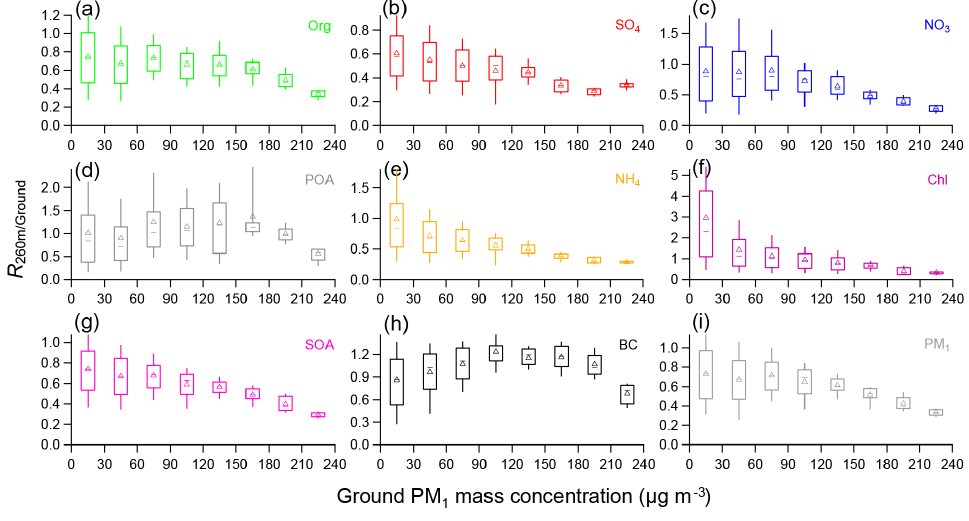
Figure 7. Variations of the ratios of 260m to ground ( R 260m/Ground ) for each species as a function of PM 1 mass concentrations at ground level. The data are grouped into eight bins according to PM 1 loadings (30µgm − 3 increments). The median (middle horizontal lines), mean (triangles), 25th and 75th percentiles (bottom and top boxes) and 10th and 90th percentiles (bottom and top whiskers) are shown for each